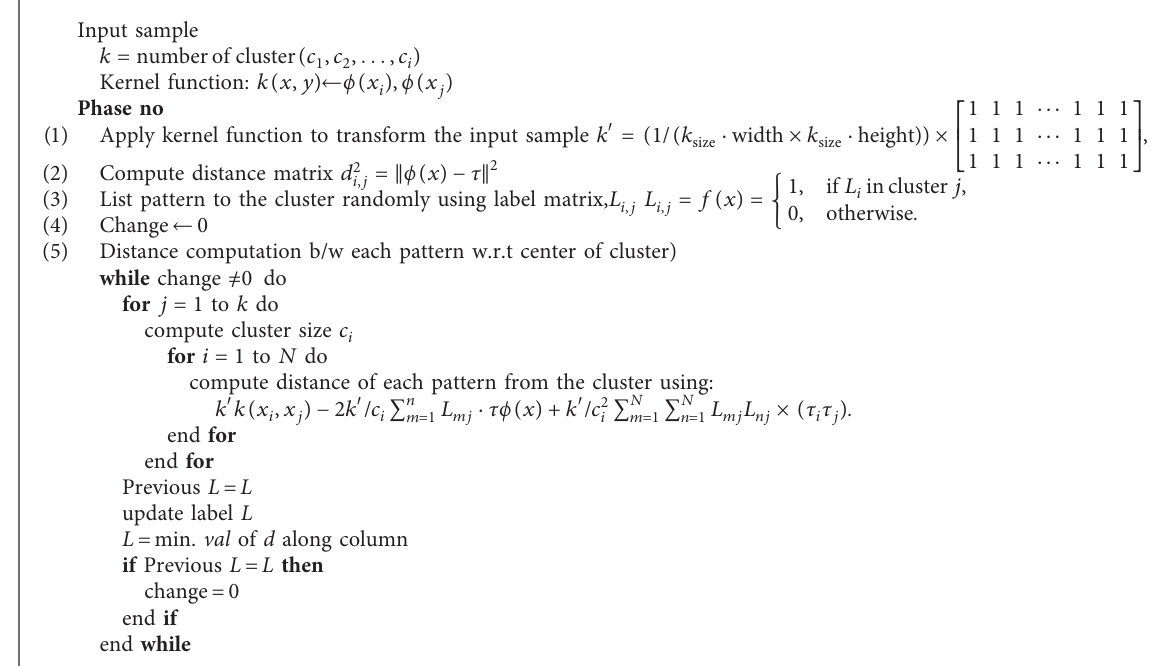
P SEUDOCODE 1: k -means using sequential